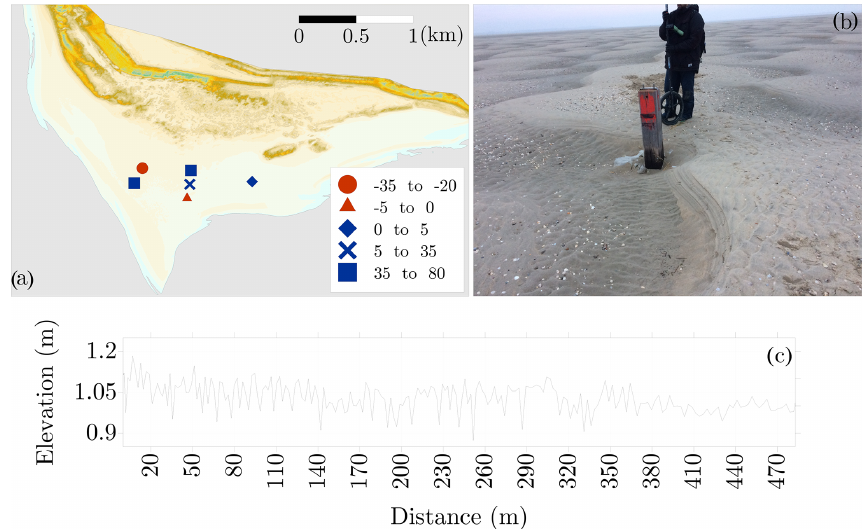
Figure 7. (a) Results from the survey, showing the change in surface elevation over the storm flooding event, in centimetres; (b) picture showing and example of bed form developed after the storm at the sand flat; (c) elevation data along the transect shown in Fig. 3 showing the bed forms formed during the storm event of January 2017.